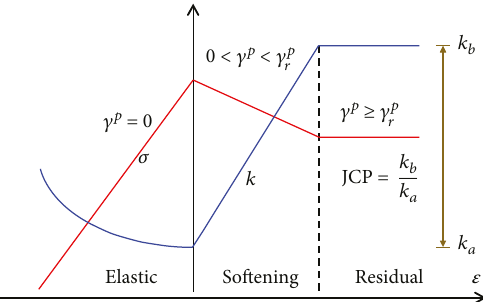
Figure 4: A conceptual model for coal permeability evolution during progressive deformation of